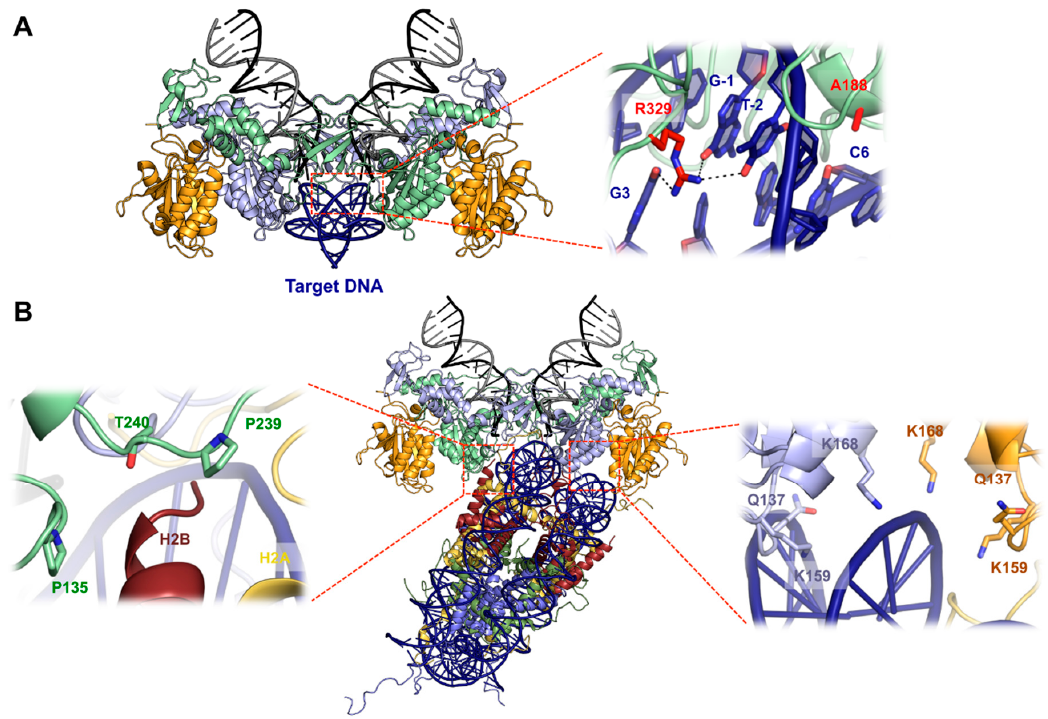
Figure 4. Target DNA capture. ( A ) Crystal structure of the target capture complex TCC (PDB: 3OS1) with sequence specific target DNA interactions shown as a blow up. Arg329 making contacts with guanosine 3, − 1, and thymine − 2, as well as Ala188 making contact with cytosine 6, are shown as red sticks. ( B ) Structure of the PFV intasome–nucleosome complex displayed as pseudoatomic model by docking PFV intasome (PDB 3L2Q) and nucleosome (PDB 1KX5) structures into the Cryo-EM map (EMDB ID 2992). Histones H2A are colored in yellow, H2B in red, H3 in blue, and H4 in green. IN contacts with H2B (left) and with the second gyre of nucleosomal DNA (right) are shown as zoomed boxes.